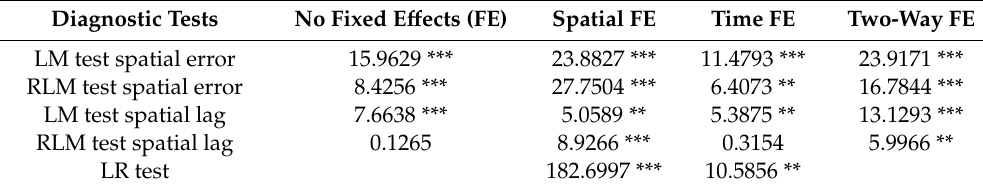
Table 3. Diagnostic tests for non-spatial panel model.